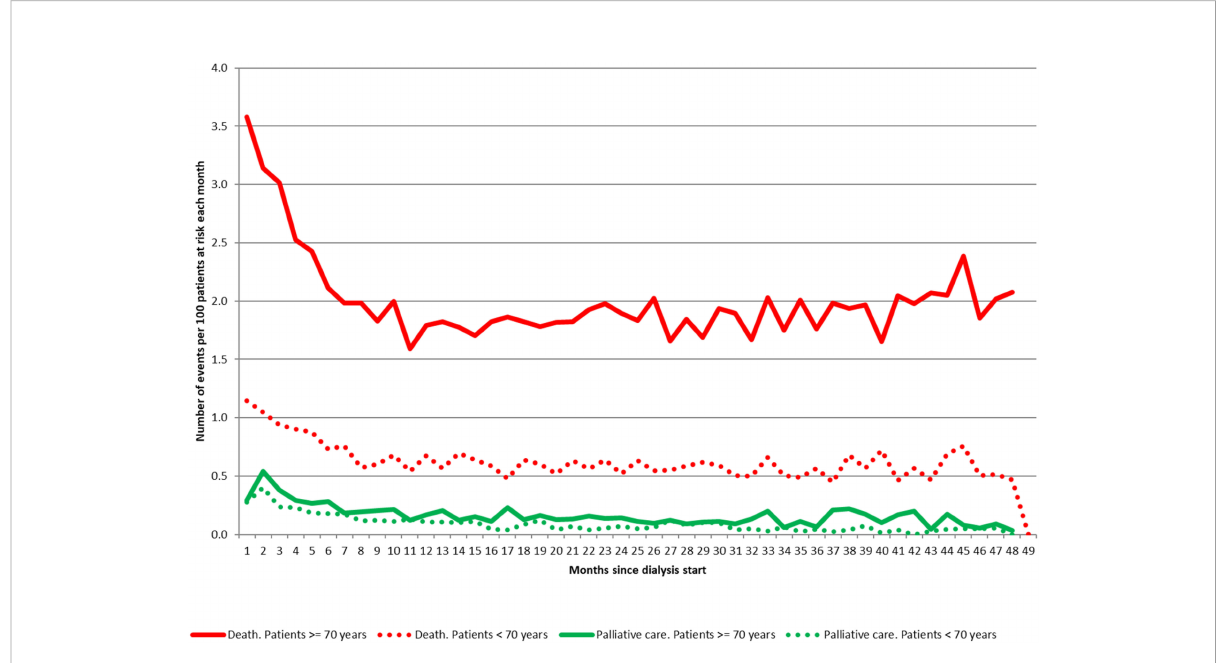
FIGURE 9 Monthly incidence rates over time of hospitalizations associated with palliative care and death from all causes during the fi rst four years after starting dialysis, according to age (source REIN registry linked to hospital database). Adapted from Couchoud et al., 2017